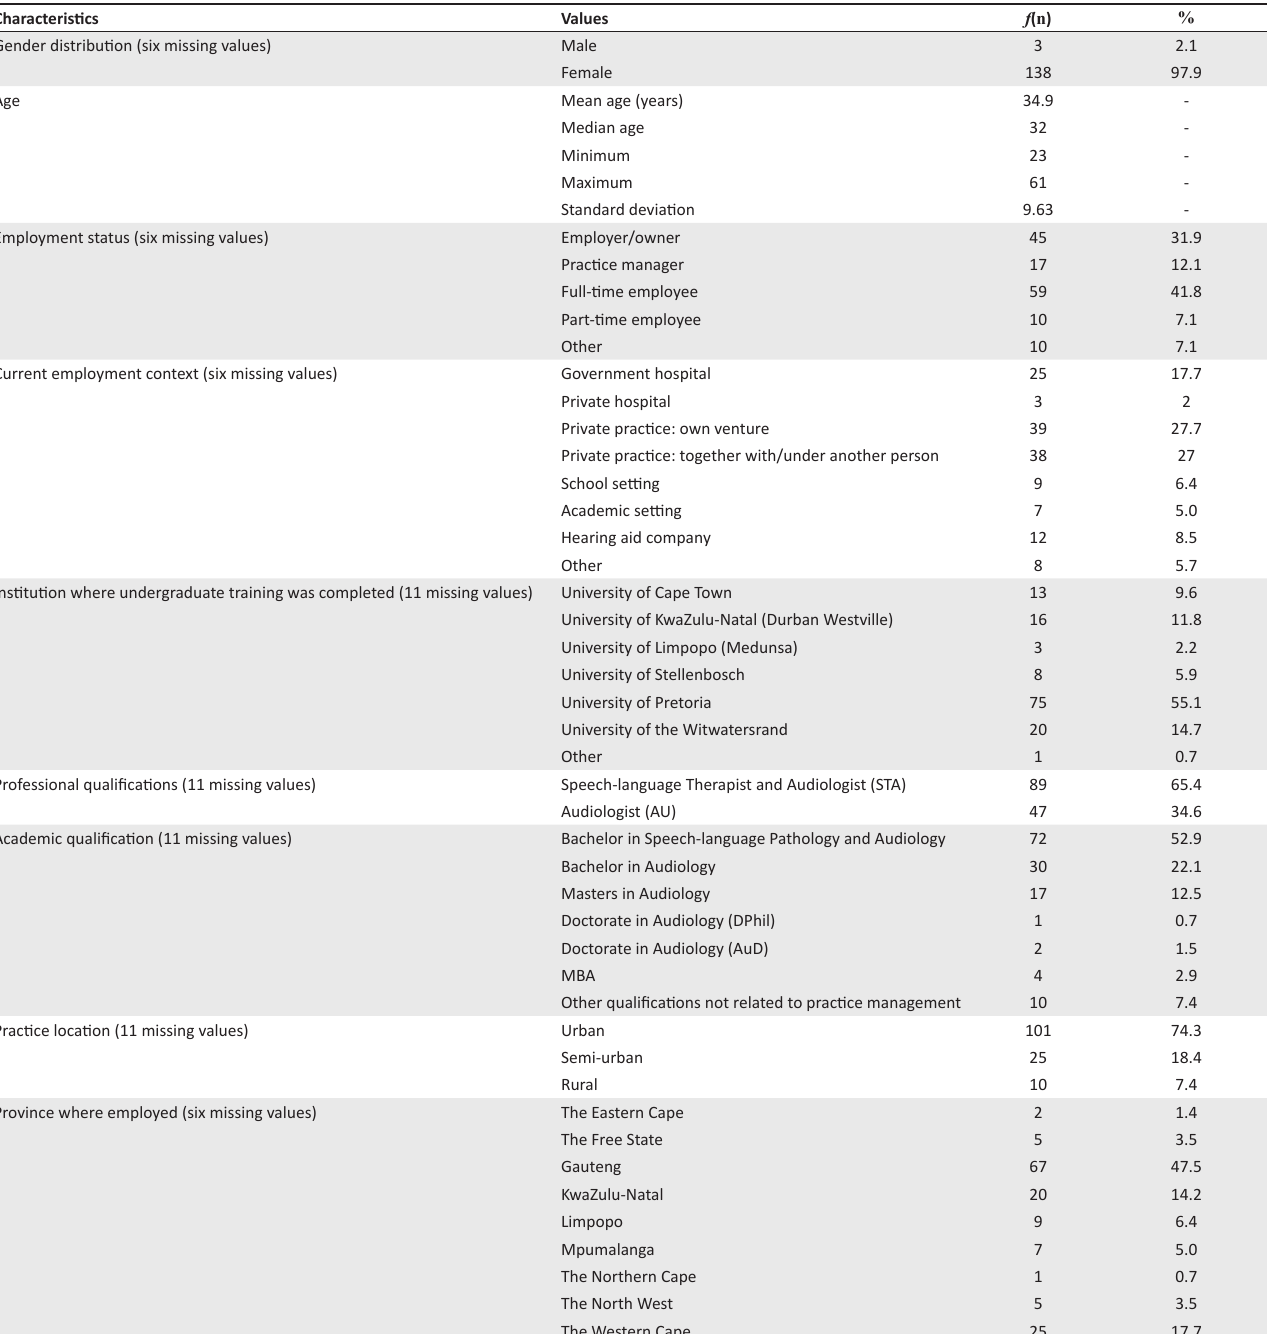
TABLE 1: Description of Respondents ( n =